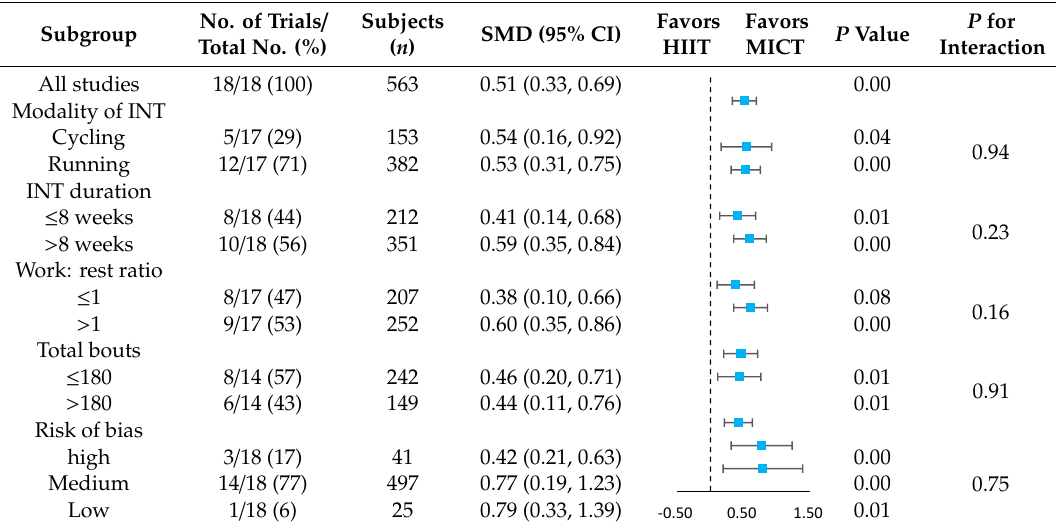
Figure 4. Results of trim and fill method (included 18 studies and 4 added studies). Table 3. Subgroup analysis of the e ff ects comparison of HIIT and MICT interventions on CRF in children and adolescents.